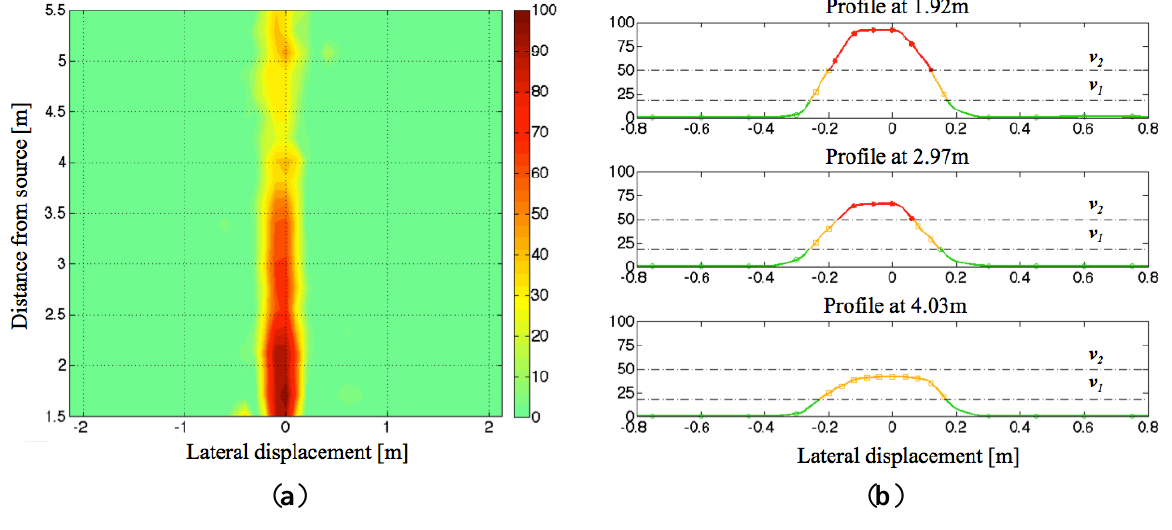
Figure 13. ( a ) Radiation map measured by the receiving subsystem on the 1 kHz channel, with antenna placed at 1m height from the floor. The color bar refers to the 8-bit analog to digital values numerically filtered after the amplification and selection chain and normalized to 100; ( b ) Profiles of the radiated field, measured at different distances from the transmitting unit. The dashed lines indicate the two different